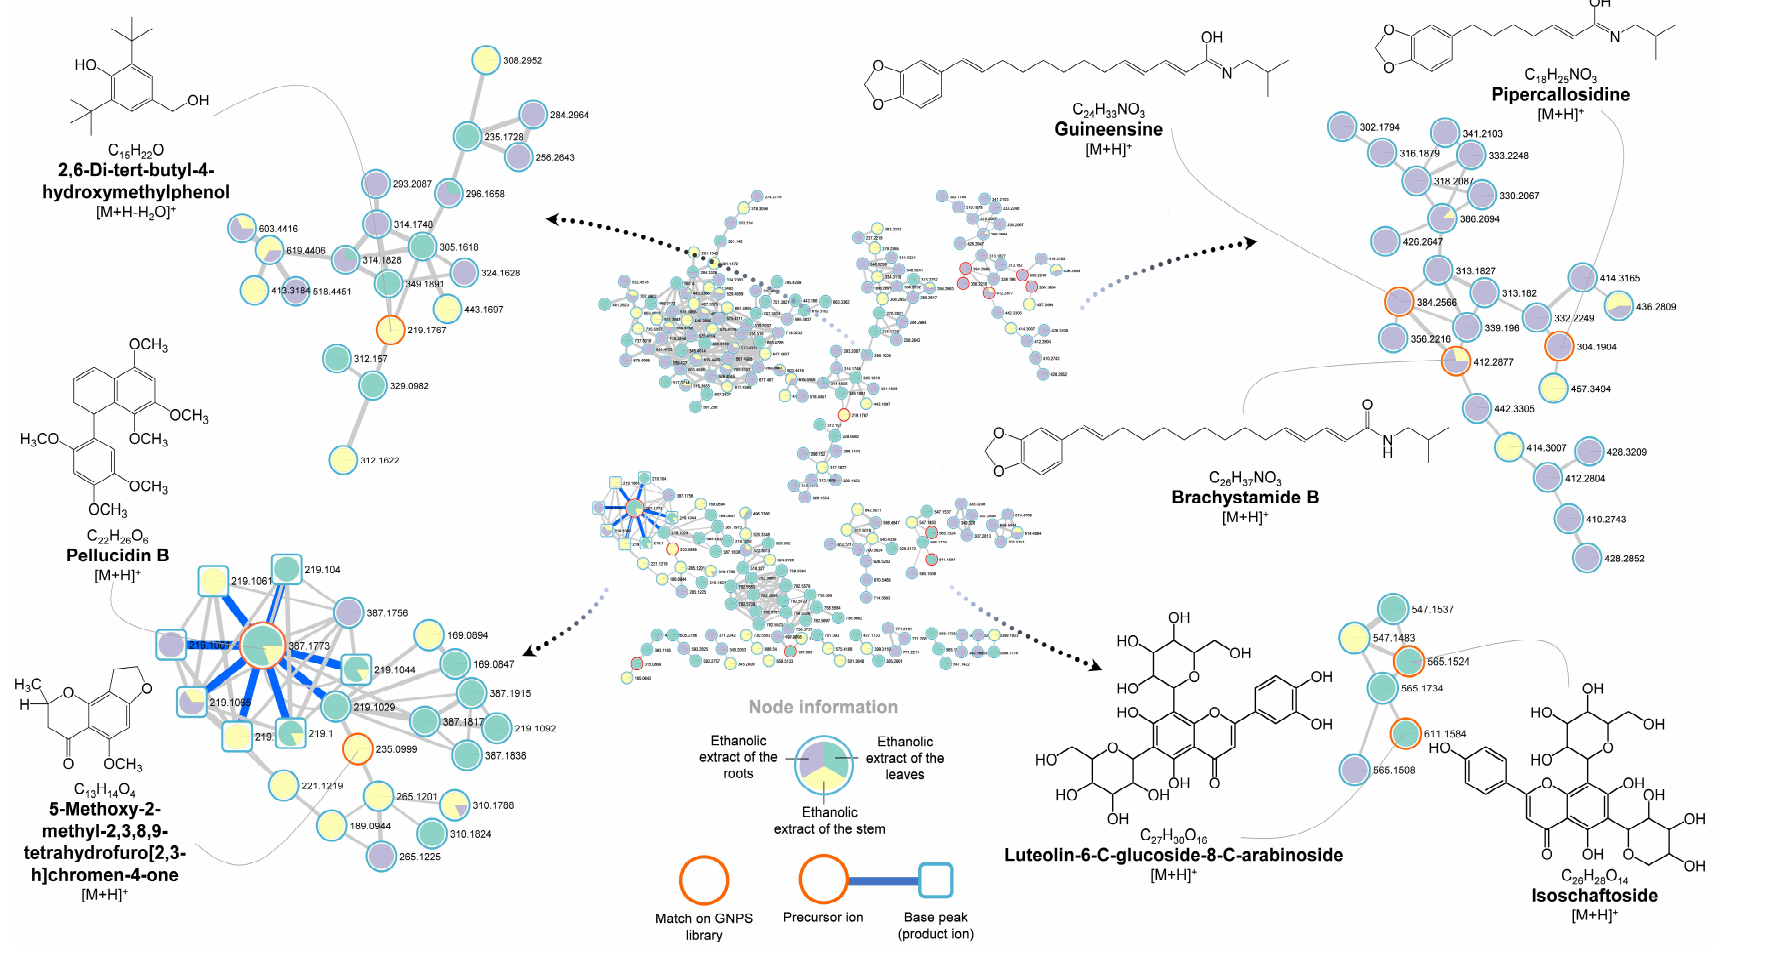
Figure 3. Selected clusters and annotation of compounds from the molecular network in positive ion mode for the ethanolic extract of the leaves, stem, and roots from P. pellucida . Numbers beside the nodes correspond to the accurate precursor mass ( m/z ), red circle: MS2 match on GNPS library, node color blue correspondent to leaves, yellow correspondent to stem, and blue correspondent to roots.